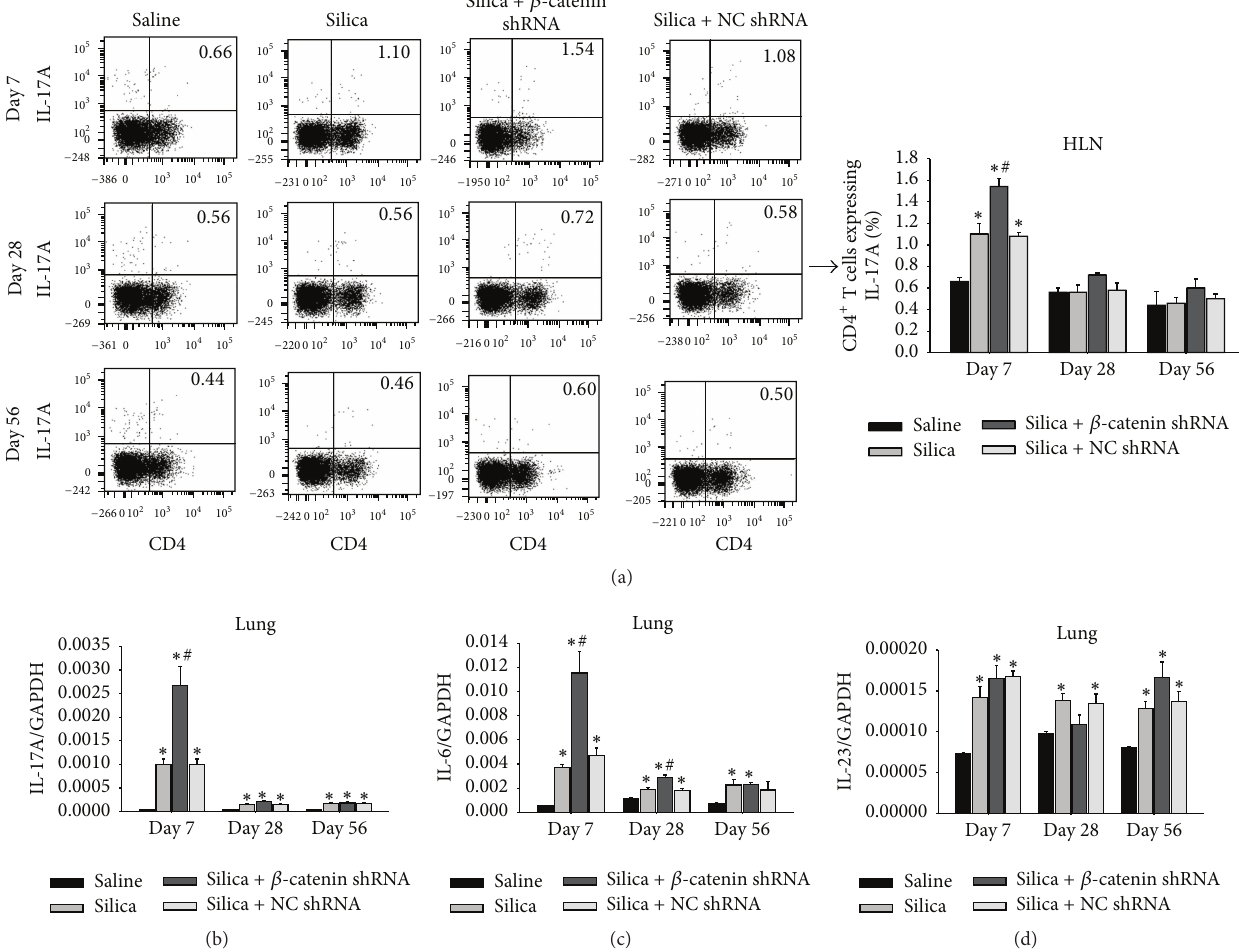
Figure 4: Th17 response was enhanced by blocking the Wnt/ 𝛽 -catenin pathway. (a) The percentage of IL-17A + CD4 + T cells in HLN was calculated by flow cytometry; data were shown as scatter plot and graph. Expressions of IL-17A (b), IL-6 (c), and IL-23 (d) in lung were assayed by real-time RT-PCR using the −ΔΔ Ct method. Values are shown as mean ± SEM ( 𝑛 = 4 -5) ( ∗ , as compared with saline group at the same time point, 𝑝 < 0.05 ; #, as compared with silica group and silica + NC shRNA group at the same time point, 𝑝 < 0.05